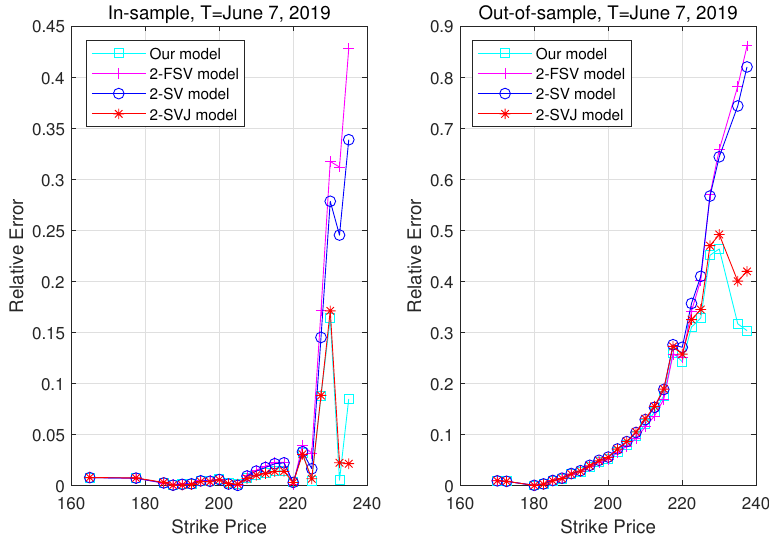
Figure 3. The comparison of predicted prices of four model specifications and market prices on 9 May 2019, with maturity T = 7 June